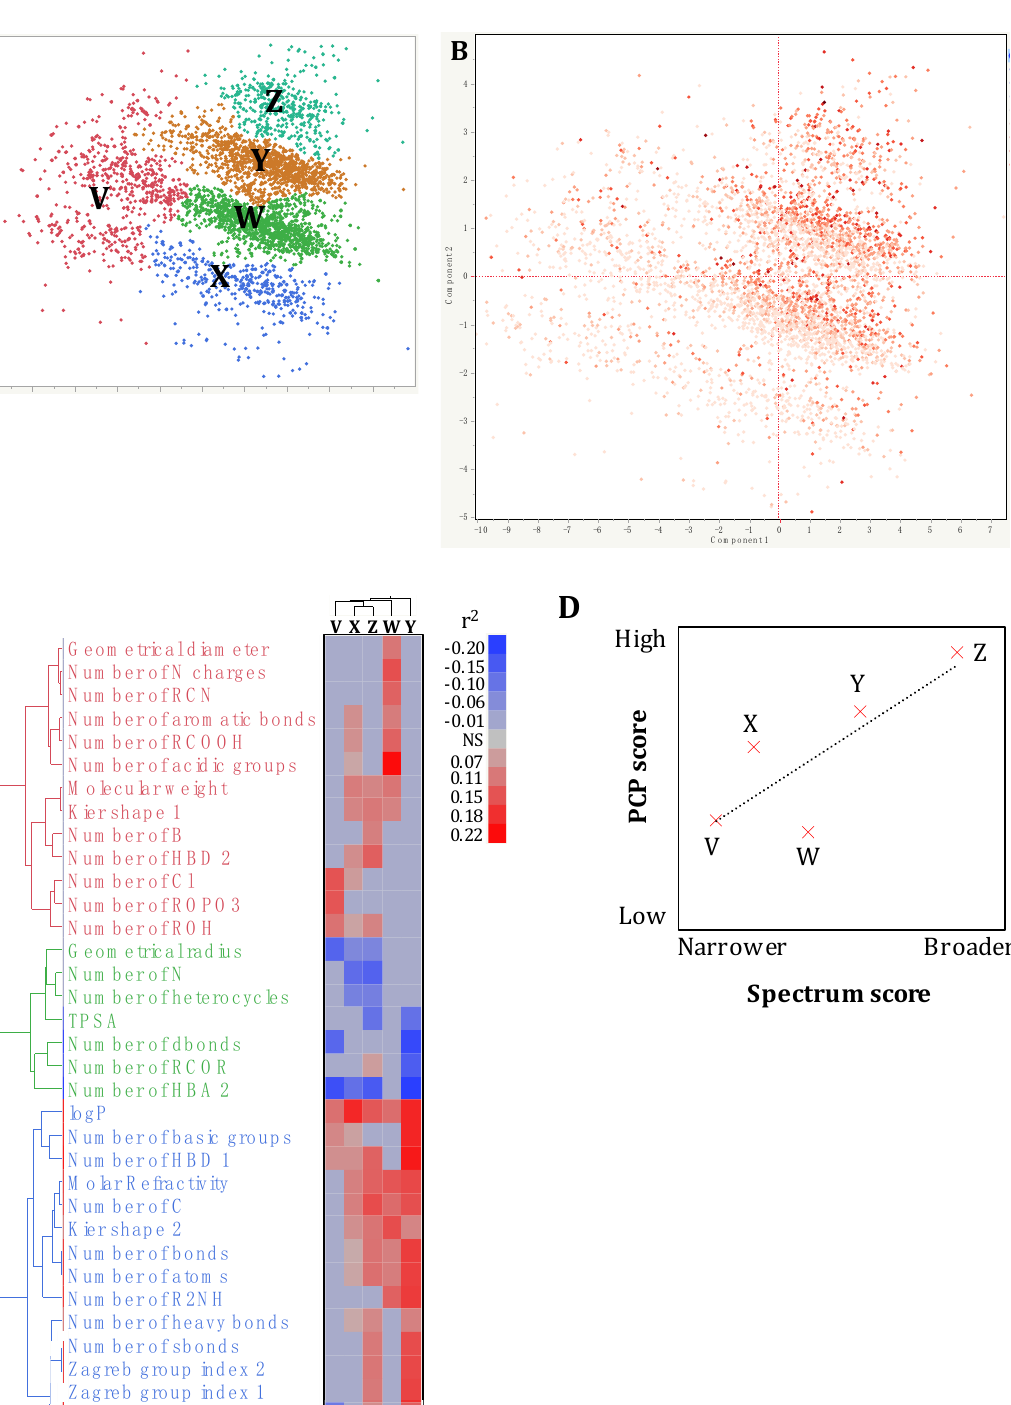
Figure 2. Impact of the physico-chemical properties (PCP) of small molecules (SM) on their antimicrobial activity and spectrum of activity. ( A , B ) Spatial distribution of the pre-selected SM library ( n = 4182) based on their PCP using a principal component analysis plot. Component 1 and 2 explained 26.8% and 9.25% of the variability across the 4182 SM based on the 60 PCP obtained from multiple reference databases (ChemBridge, PubChem, Joelib, ChemMine, and OpenBabel). Each dot represents the distribution of a SM based on its PCP. ( A ) displays the clusterization of the SM library into 5 distinct clusters based on the PCP of the SM. ( B ) displays the spectrum of activity of each SM (dot) based on the published primary screening data. The color of the dots is proportional the spectrum of antimicrobial activity of a given SM based on the primary screenings performed (number of species affected by the SM; from 0 to 8 species). Cluster V ( n = 594 SM), W ( n = 1396 SM), X ( n = 404 SM), Y ( n = 1355 SM), and Z ( n = 433 SM). ( C ) The two-way clustering plot was built based on the 34 PCP showing significant correlations with the spectrum of antimicrobial activity of the SM. Five clusters were generated